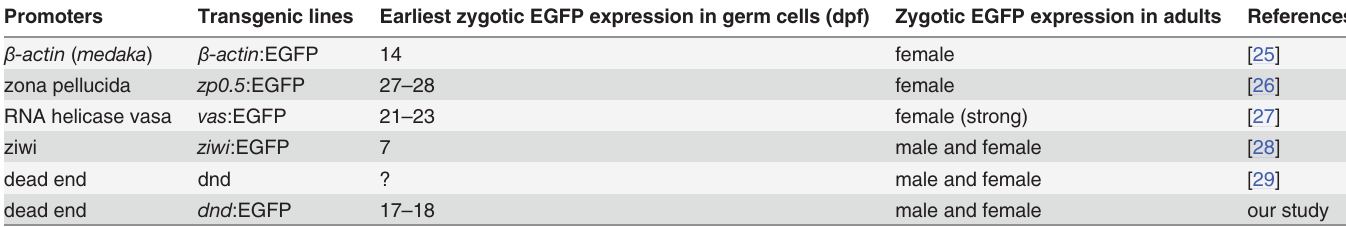
Table 1. Several transgenic zebra fi sh for germ cell visualization in vivo